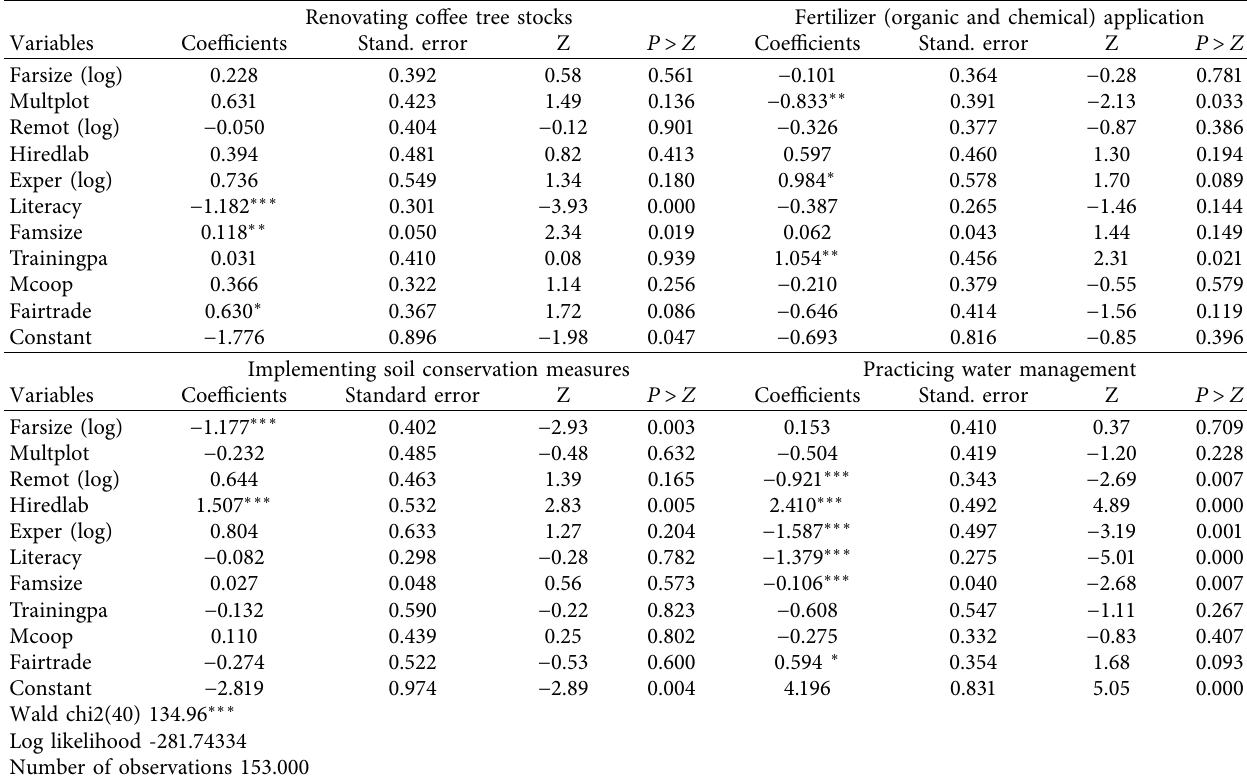
Table 3: Coefficient estimates of the MVP